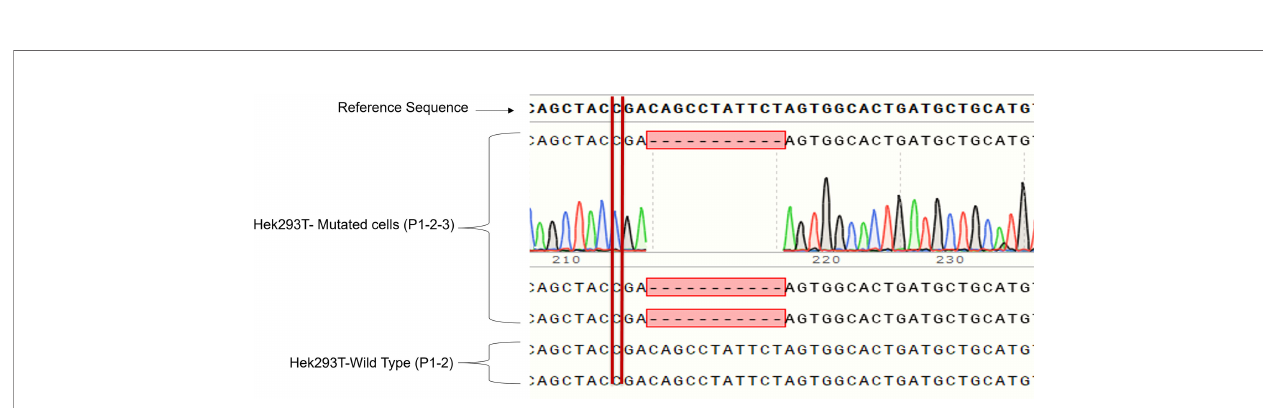
FIGURE 3 | Sanger sequencing of the fi rst three passages of sorted HEK293T cells with GLUT2 mutation. The deletion mutation was con fi rmed in the fi rst three passages of the sorted cell colony to validate cell genotype.